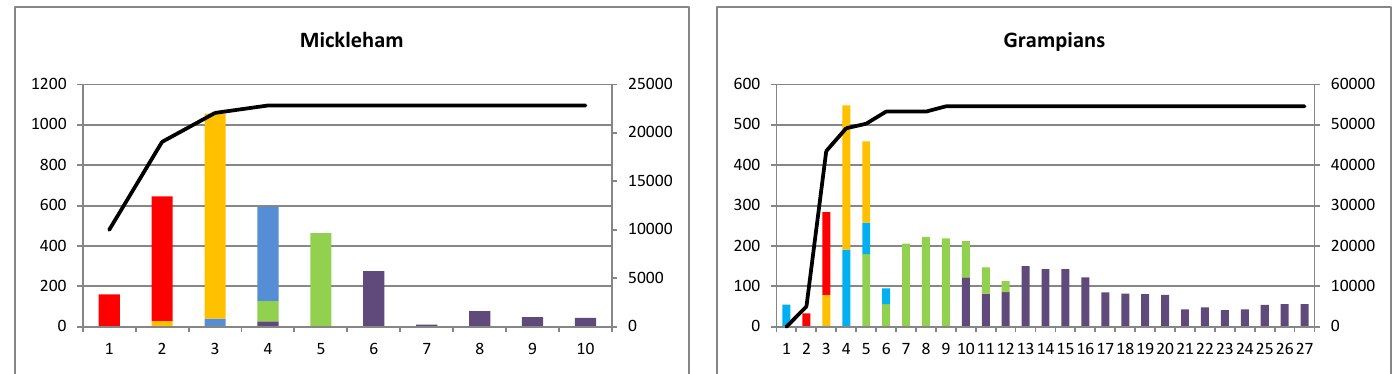
Figure A12. Total ground-crew classified by stage for each day of the fire (see Stonyford graph for axis labels and legend).